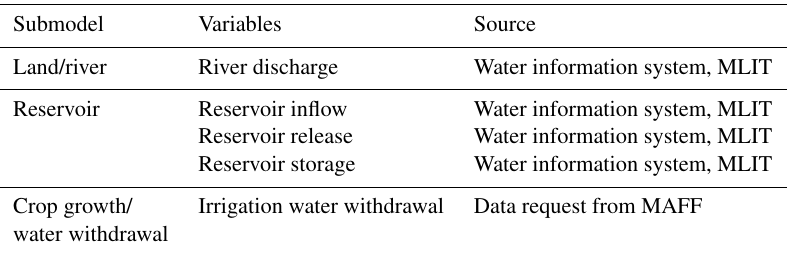
Table 4. Validation data. MLIT and MAFF represent the Ministry of Land Infrastructure, and Transportation and the Ministry of Agriculture, Forestry, and Fisheries,